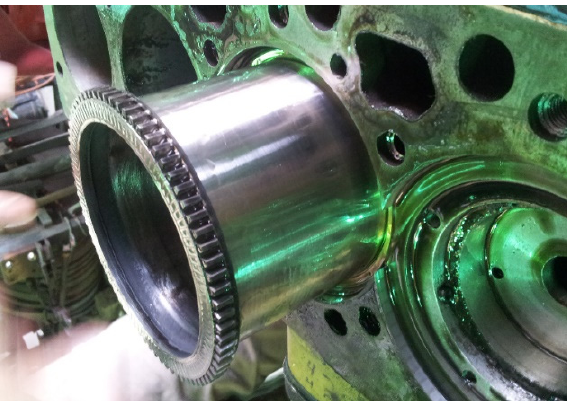
Figure 6. Rotating liner pulled a few inches out of the block, exposing the outside surface.